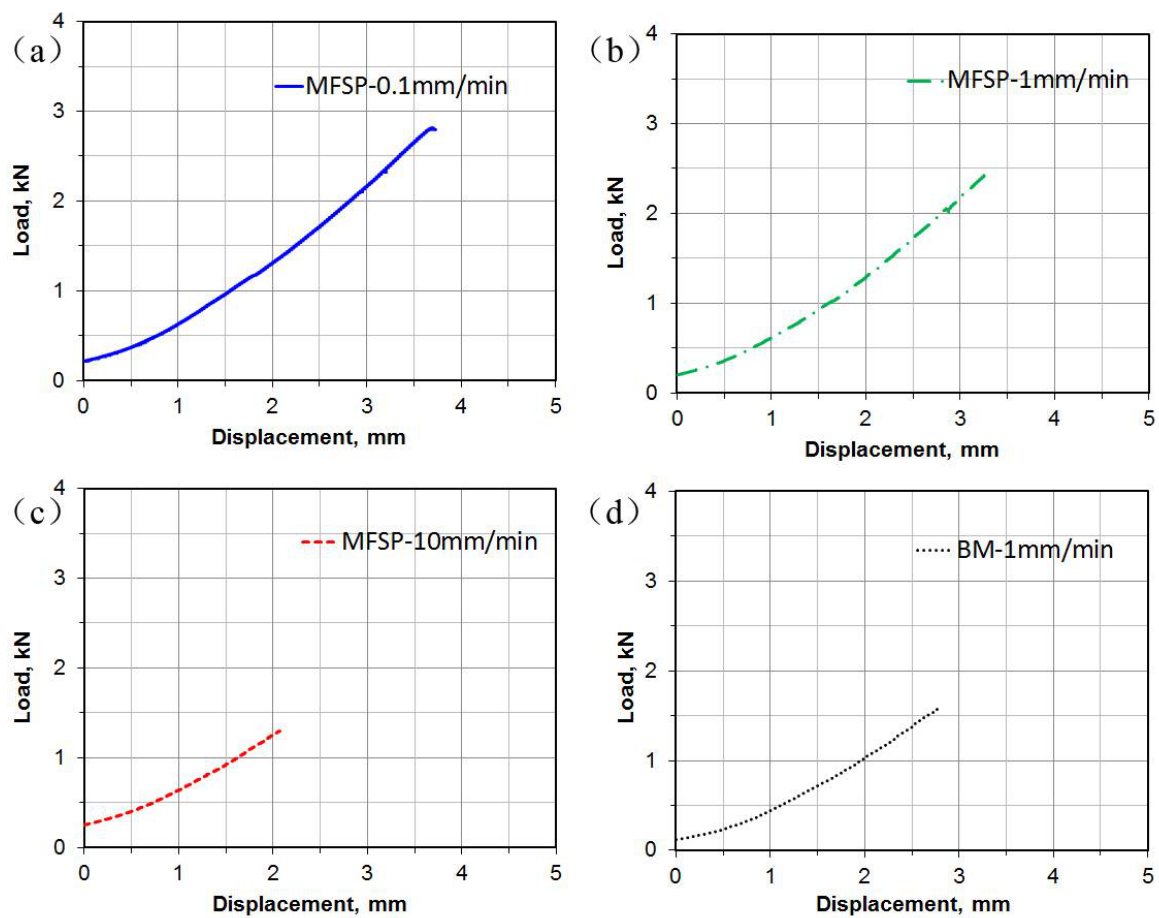
Figure 3. Typical load-displacement curves during Erichsen cupping tests at different punching speeds of ( a ) 0.1 mm/min; ( b ) 1 mm/min; ( c ) 10 mm/min for the M-FSP samples; and ( d ) at 1 mm/min for the base material (BM).